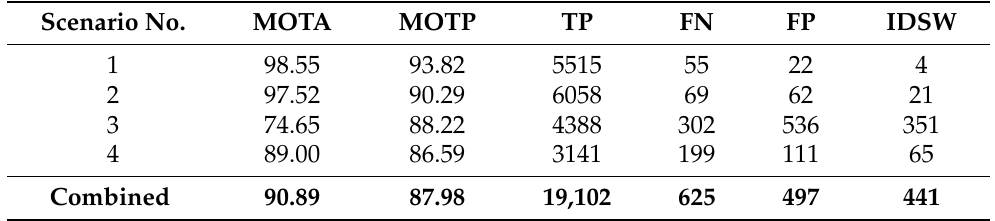
Table 10. This table pretenses a weighted average sum of results conducted from experiments 1 and 2. It shows the overall performance of the tracker across scenarios and